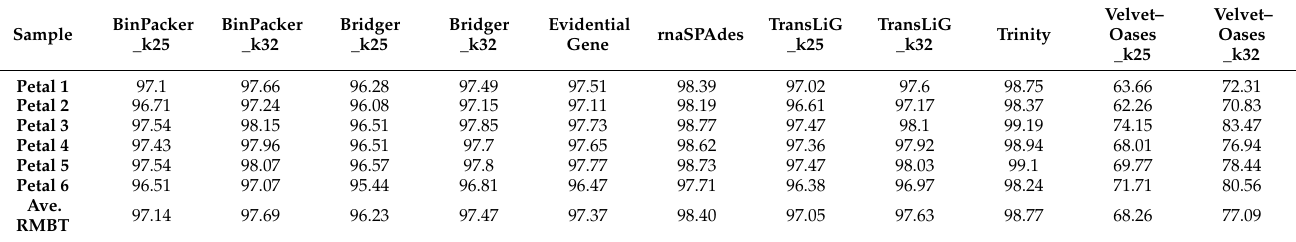
Table 1. Percentage of reads mapped back to each transcriptome (RMBT) of L. ledebourii